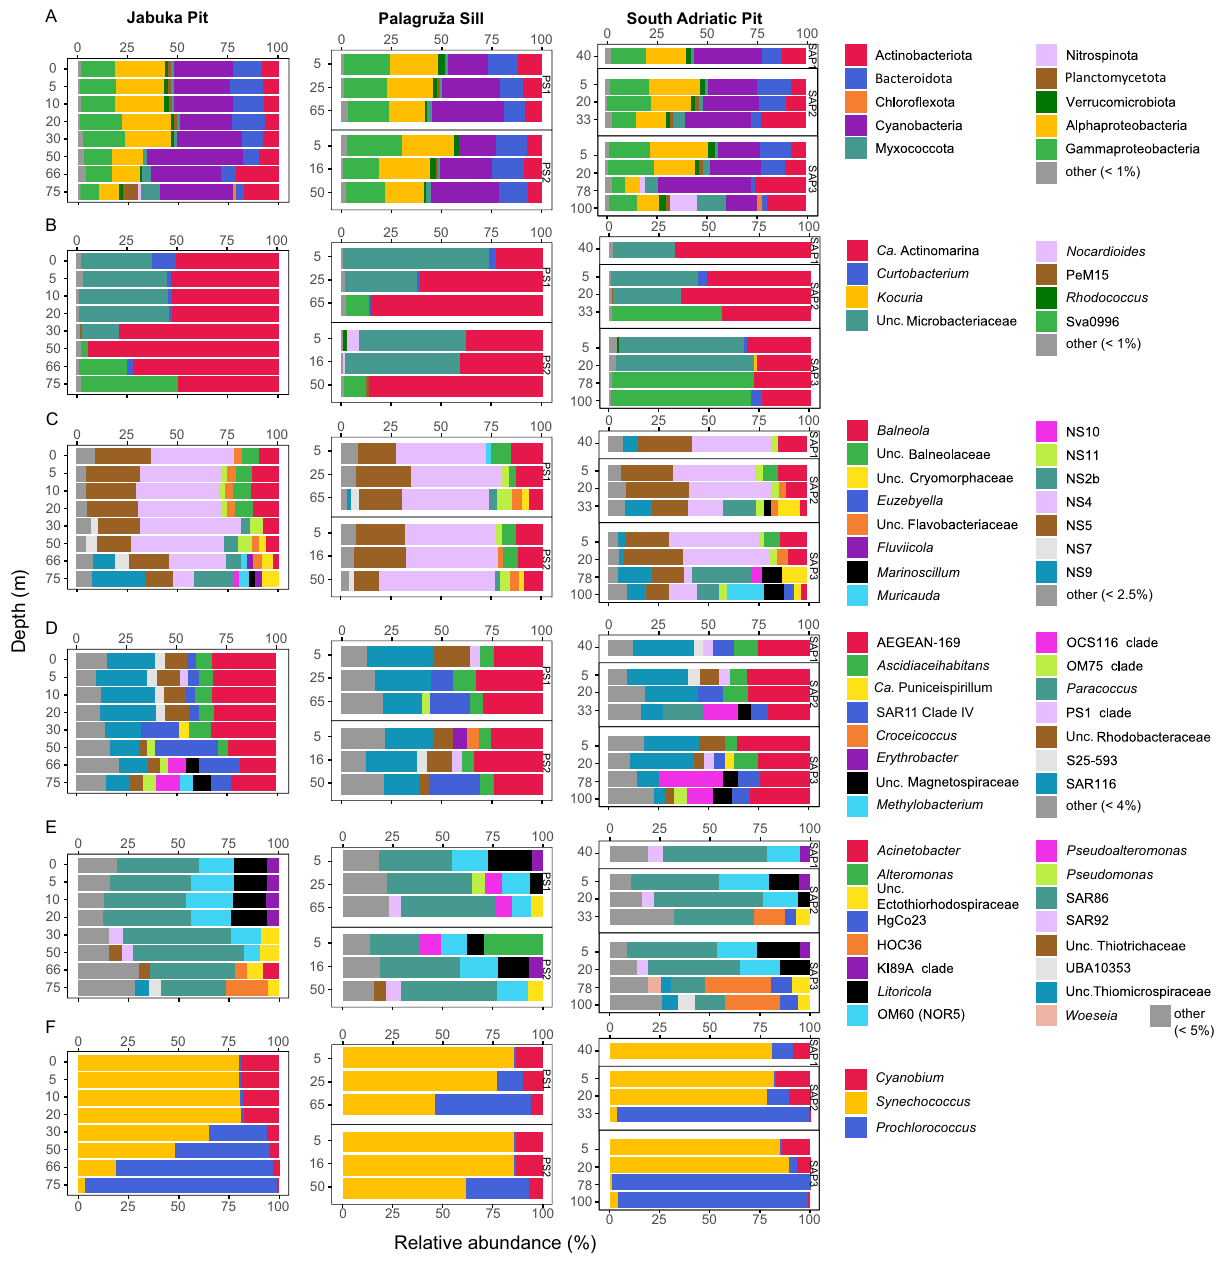
Figure 3. Bacterial community composition (BCC) in the Jabuka Pit (JP), Palagruža Sill (PS) and South Adriatic Pit (SAP). For the most abundant phyla or classes BCC as the genus level is shown. ( A ) Relative contribution of the bacterial phyla and proteobacterial classes ( B ) Genus contribution in the Actinobacteriota ( C ) Genus contribution in the Bacteroidota ( D ) Genus contribution in the Alphaproteobacteria ( E ) Genus contribution in the Gammaproteobacteria ( F ) Genus contribution in the Cyanobacteria. Category ‘other’ groups taxa with the relative abundances below the threshold given in the parentheses. The figure was generated in R statistical software 35 (https:// cran.r- proje ct. org/ , v. 3.6.3), using ggplot2 v. 3.3.3 package 36 , and they were assembled in Inkscape (https:// inksc ape. org/ , v.